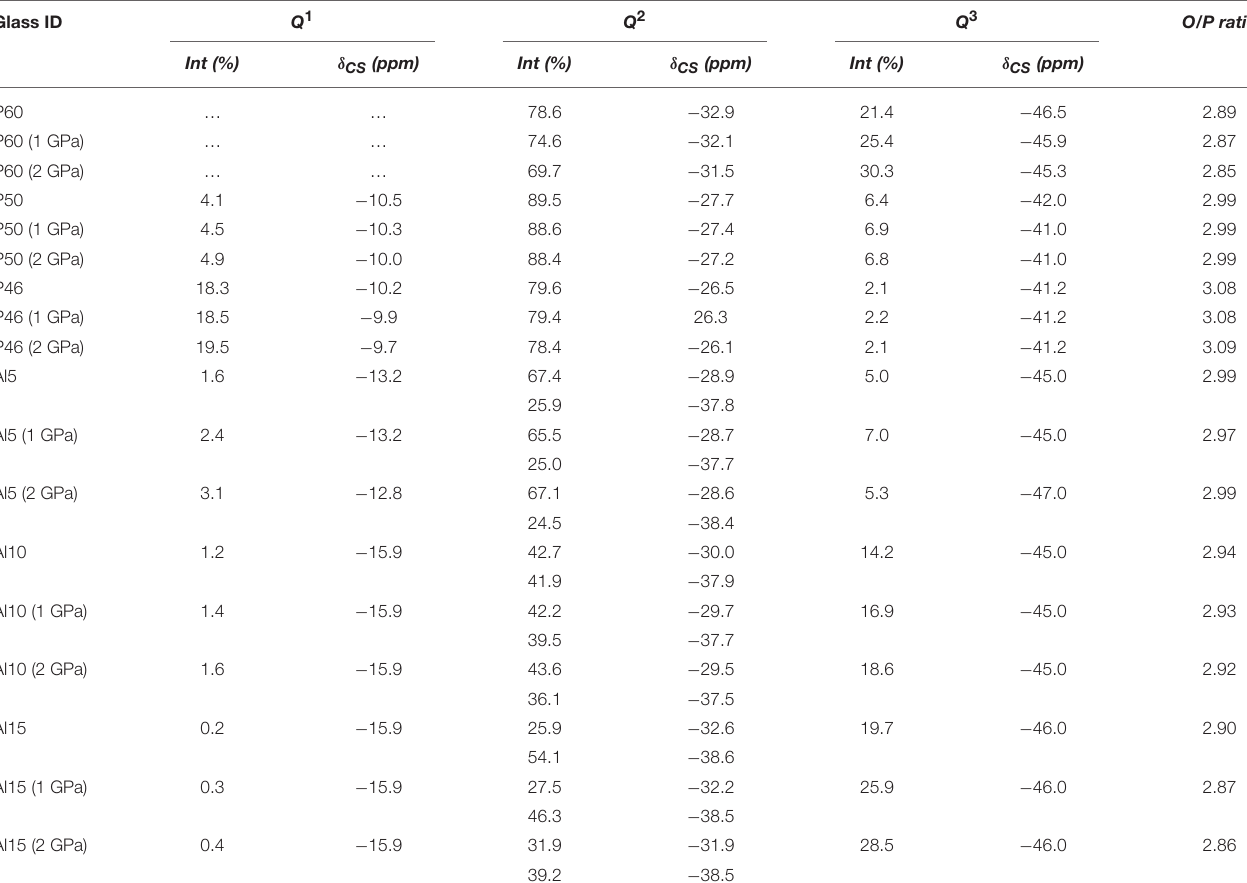
TABLE 2 | Phosphorus speciation obtained by deconvolution of 31 P MAS NMR spectra. Glass